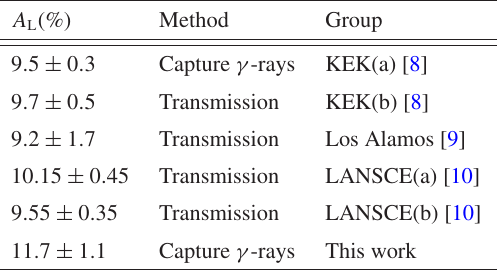
Table 1. Values of A L as measured in previous